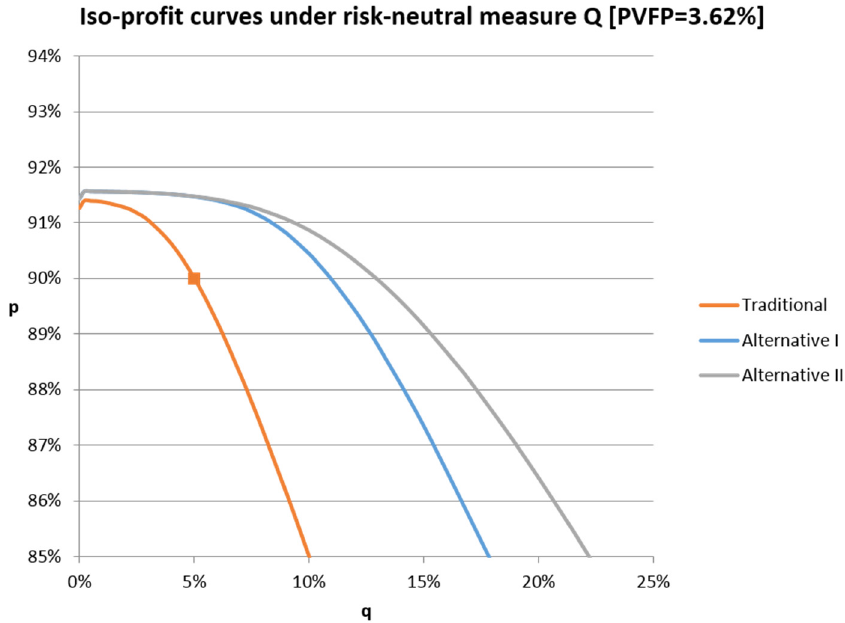
Figure 1. Iso-profit curves with PVFP “ 3.62% (based on the traditional product with p “ 90% Figure 1. Iso ‐ profit curves with (cid:2172)(cid:2178)(cid:2162)(cid:2172) (cid:3404) (cid:2780). (cid:2783)(cid:2779)% (based on the traditional product with (cid:2198) (cid:3404) (cid:2786)(cid:2777)% and q “ 5% and (cid:2199) (cid:3404) (cid:2782)% ).